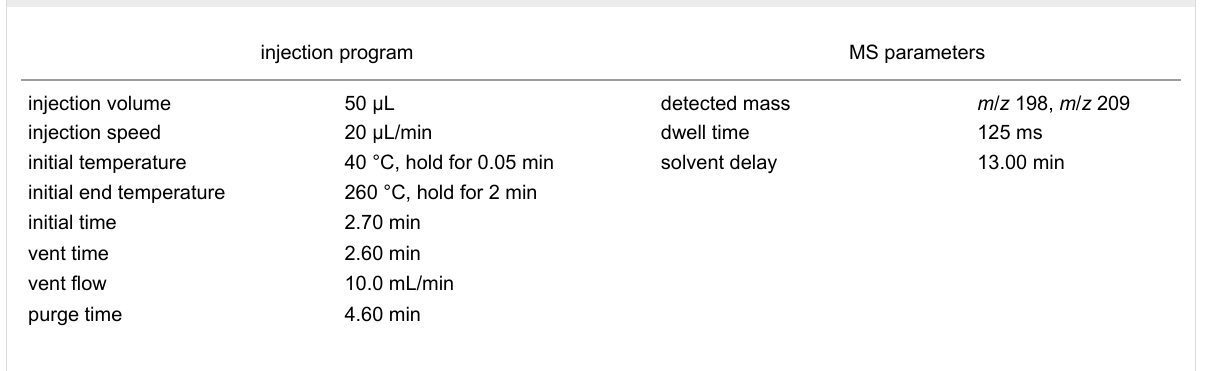
Table 2: GC–MS parameters for PCI analysis of GF